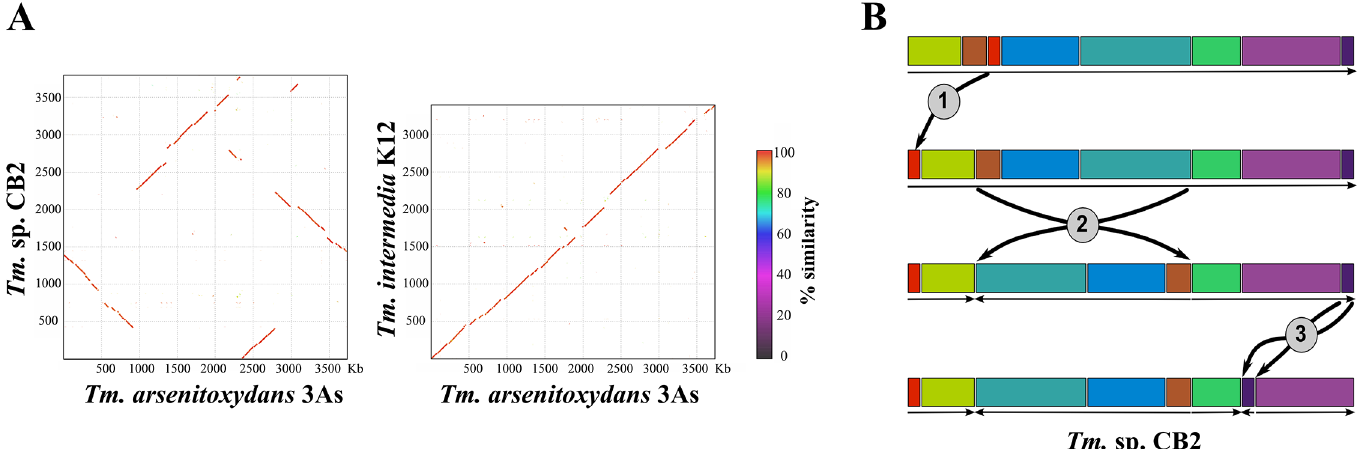
Fig 2. Comparison among the CB2, K12, and 3As genomes. (A) Dot plot, CB2 vs 3As and 3As vs K12. The genomes of 3As and K12 are well conserved while the CB2 genome appears to have undergone chromosomal rearrangements. (B) Scheme demonstrating the key differences between the Thiomonas ancestor and CB2 genome. Above, “ 1 ” , “ 2 ” and “ 3 ” highlight a translocation of 0.1 Mb, an inversion of 1.8 Mb and a translocation and inversion of 0.13 Mb, respectively.